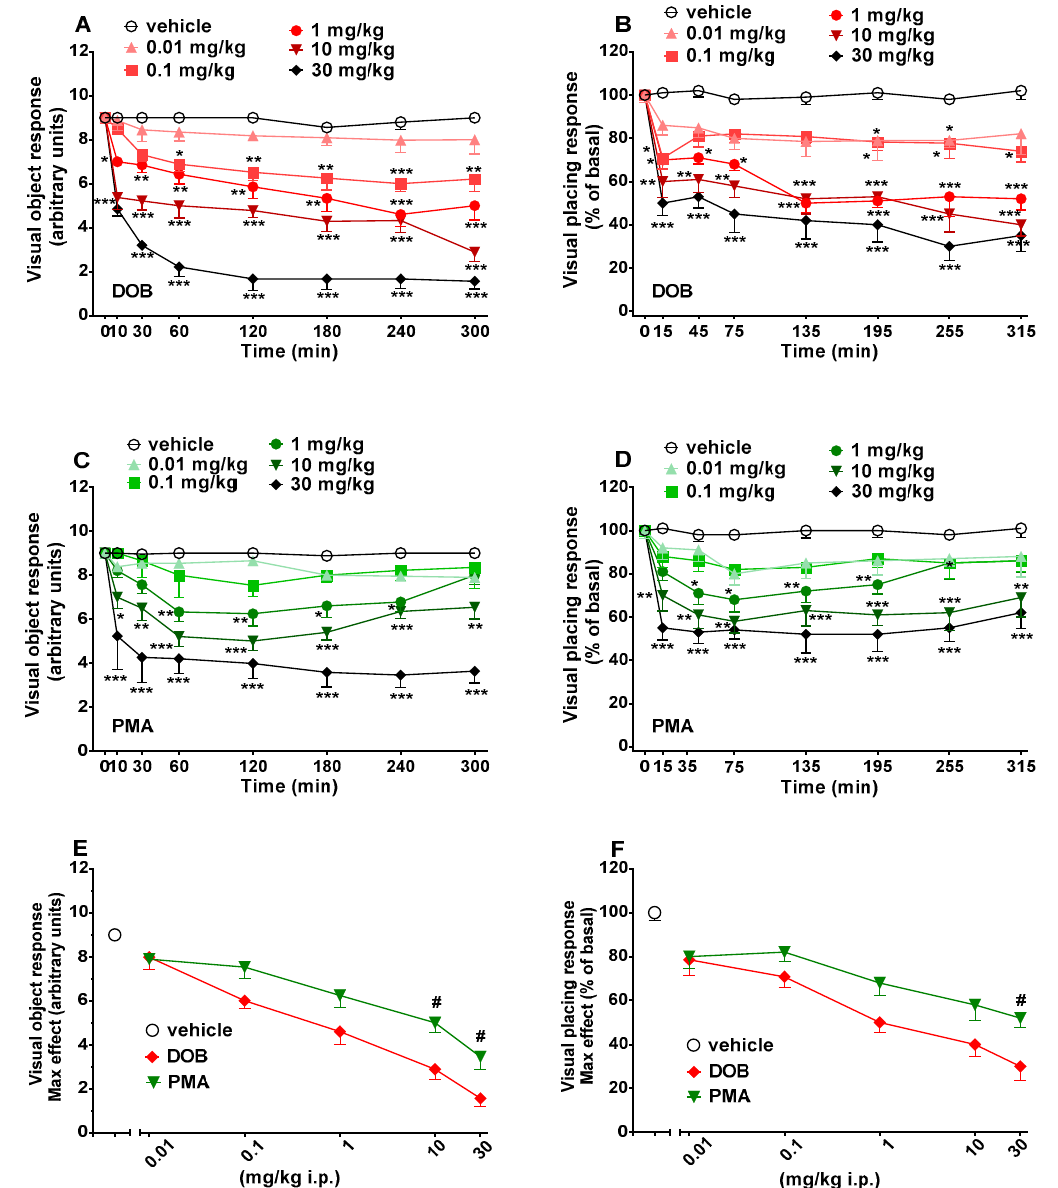
Figure 2. Effect of DOB (0.01–30 mg/kg i.p.; panels A and B ) and PMA (0.01–30 mg/kg i.p.; panels C and D ) on the visual object ( left ) and placing response ( right ) tests in the mice and comparison of the maximum effect observed in 5 h on visual object (panel E ) and visual placing (panel F ) tests. Data are expressed as mean ± SEM (n = 8/group). Statistical analysis was performed by two-way ANOVA followed by Bonferroni’s test (panel B , D and E ), Dunnett’s test (panel A , C and F ) for multiple comparisons for the dose–response curve of each compound at different time points (panels A – D ). The comparison of maximum effect observed in 5 h was also presented (panels E and F ). * p < 0.05, ** p < 0.01, *** p < 0.001 versus vehicle; # p < 0.05 versus DOB.